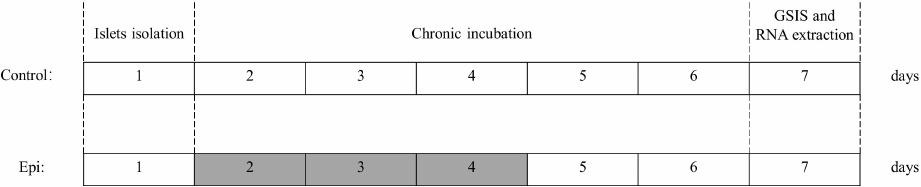
Figure 1. Study design for chronic epinephrine exposure on islets. The islets were incubated in standard culture media suppled with 100 nM epinephrine (grey box) or vehicle (open box) for three days. Then, after removal Epi exposure, islets of Epi group was allowed to grow for two days before insulin secretion responsiveness test. Epi, epinephrine; GSIS, glucose stimulated insulin secretion. Schemes follow the same